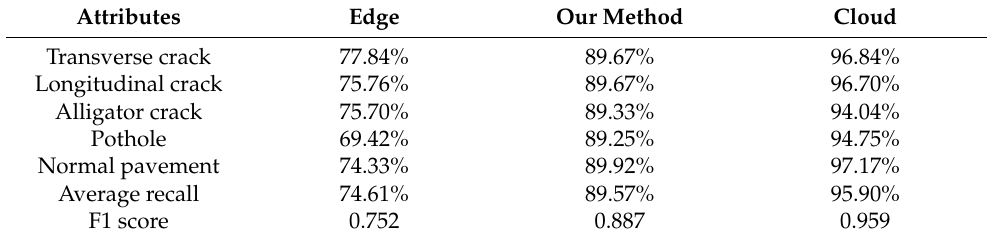
Table 1. Average recall and F1 score for various road surface images on datasets only at the edge, in our method, and in the